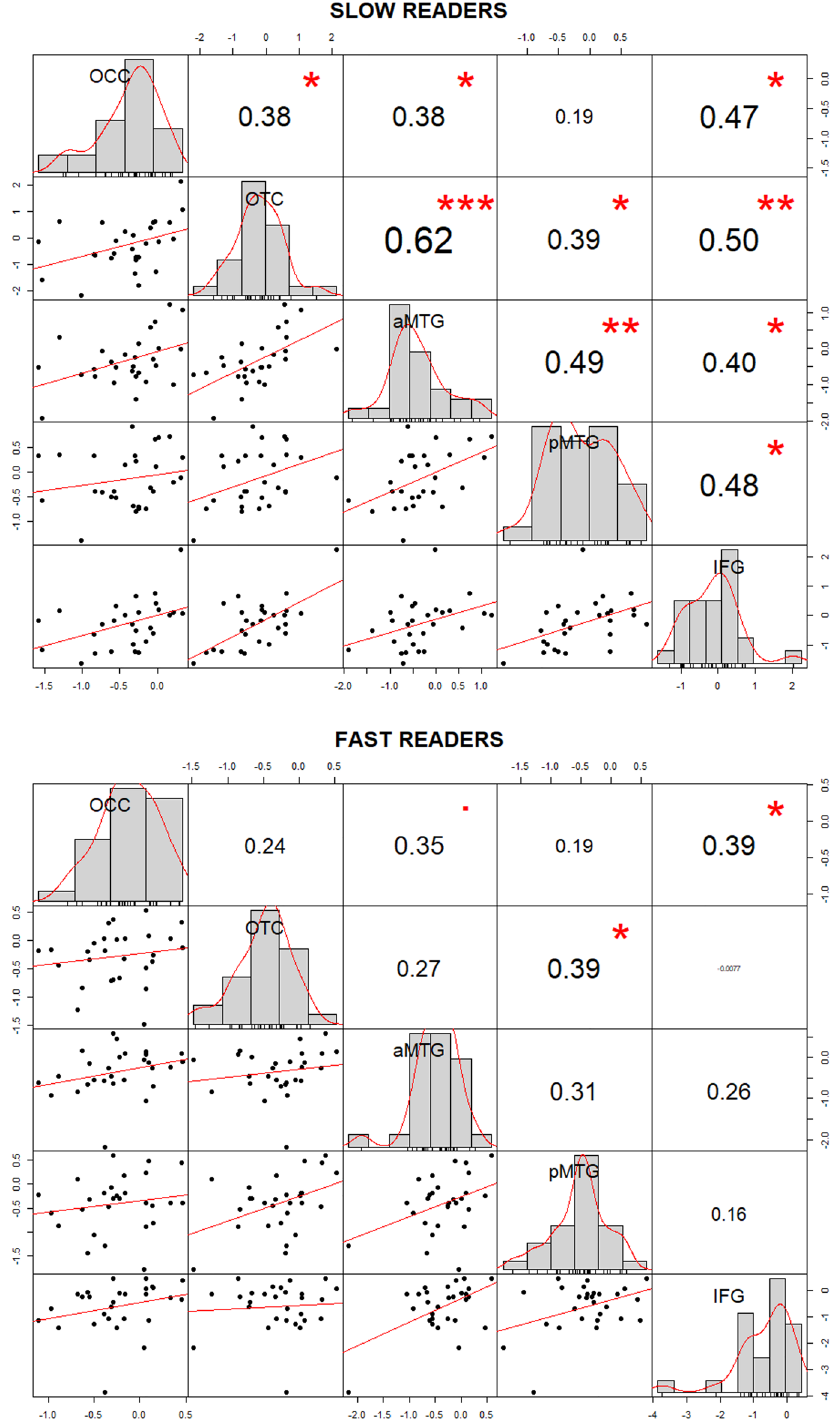
Figure 3. Scatter plots, histograms and correlation coefficients of our ROI-to-ROI analysis in slow (upper panel) and fast readers (lower panel). Significant spearman rank correlations are marked by asterisks: * p < 0.05, ** p < 0.01, *** p <